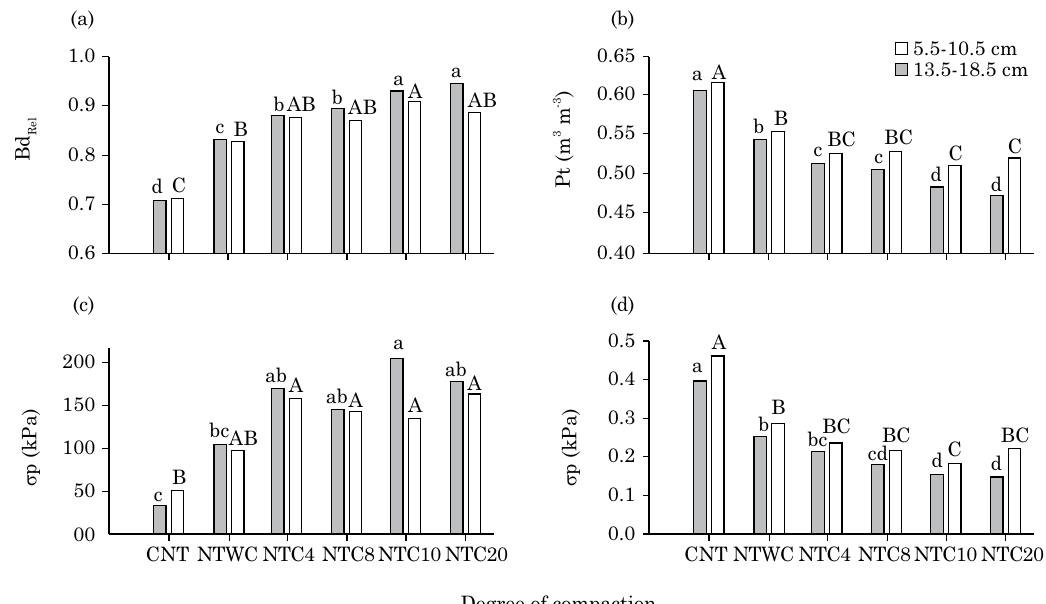
Figure 1. Relative bulk density (Bd rel ) (a), total porosity (Pt) (b), preconsolidation pressure (σp) (c), and compression index (CI) (d) as related to degrees of compaction [no-tillage (NT) chiseled (CNT); NT without additional compaction (NTWC); NT with additional compaction of a combine passing 4 (NTC4), 8 (NTC8), 10 (NTC10), and 20 (NTC20) times] over a Rhodic Eutrudox. Means followed by the same uppercase letter (5.5 - 10.5 cm layer) or lowercase letter (13.5-18.5 cm layer) do not differ by the Tukey test